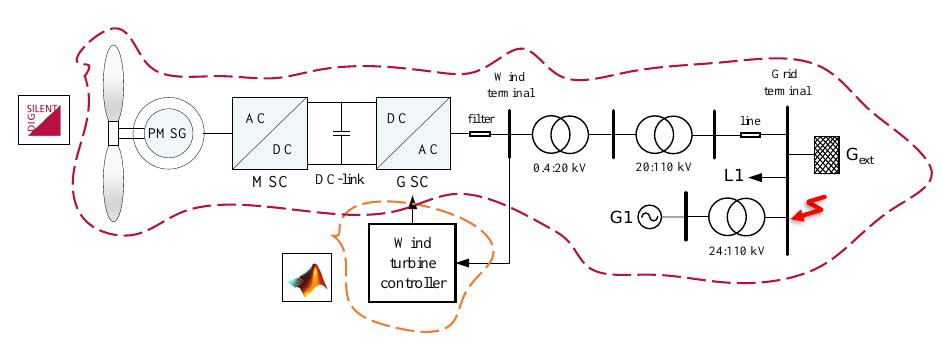
Figure 4. System under test for testing the co-simulation efficacy.